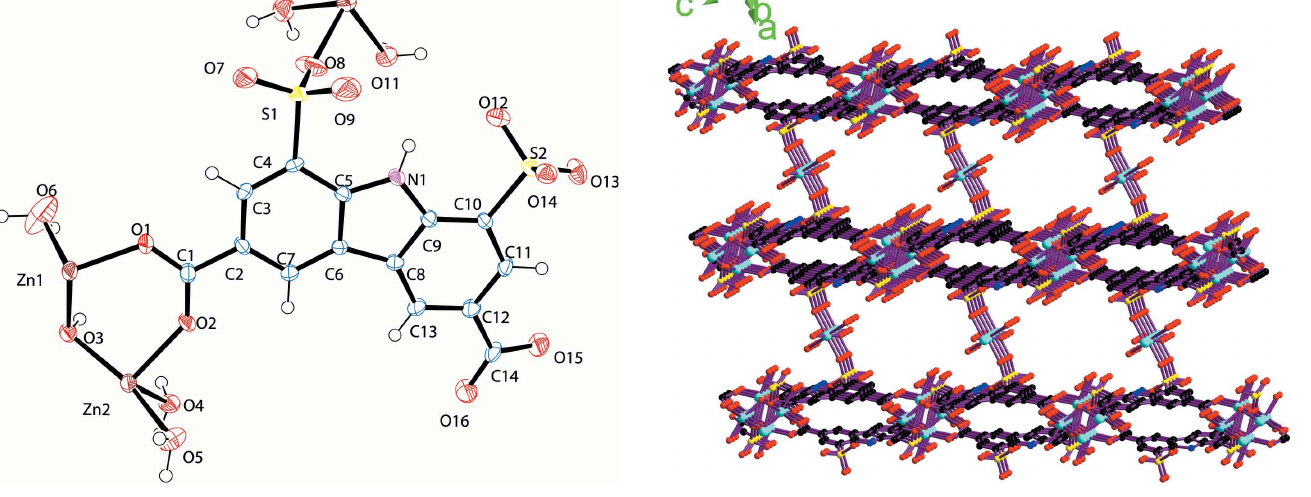
Figure 2 A view of the three-dimensional structure of (I); H atoms have been omitted for reasons of clarity.